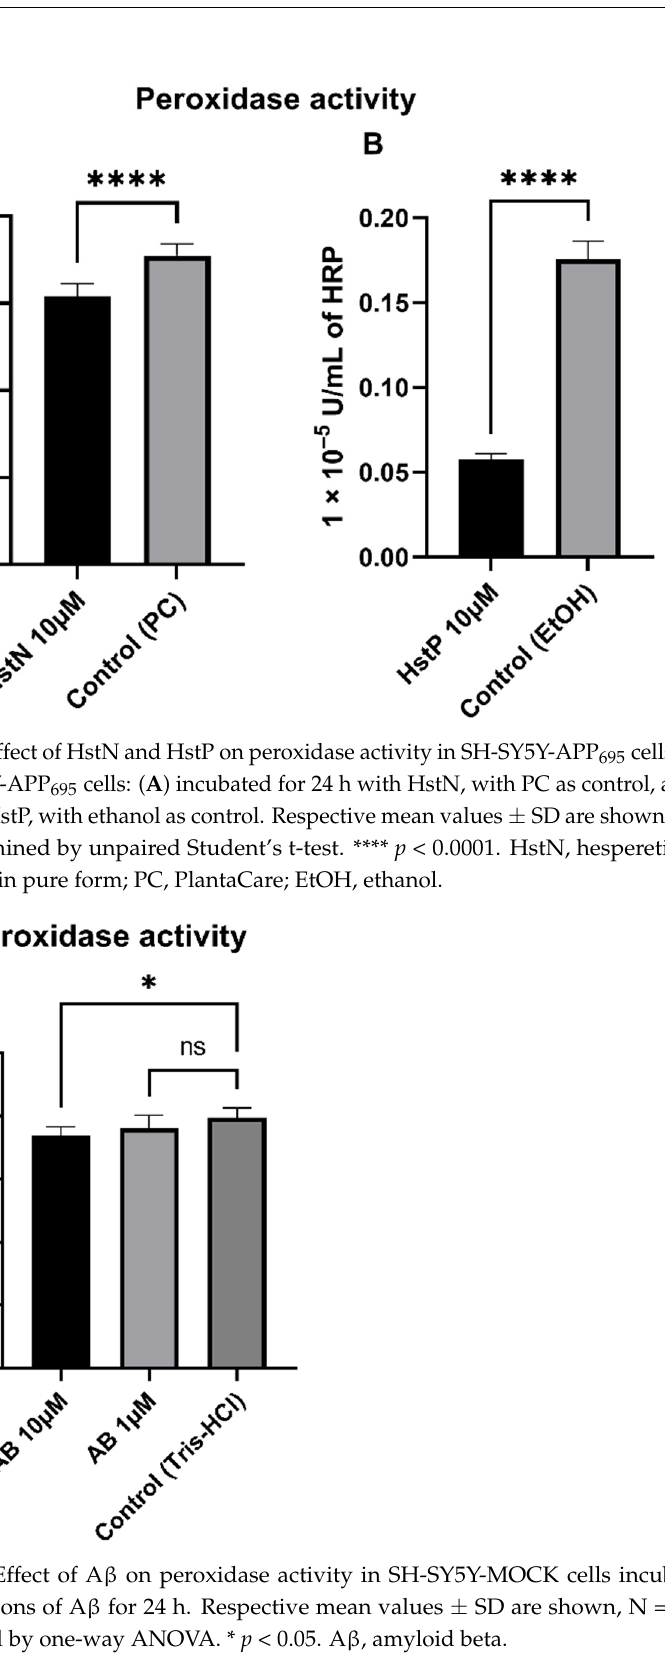
Figure 7. Effect of A β on peroxidase activity in SH-SY5Y-MOCK cells incubated with different con- centrations of A β for 24 h. Respective mean values ± SD are shown, N = 7. Significance was deter- mined by one-way ANOVA. * p < 0.05. A β , amyloid beta. 3.8. Peroxidase Activity of Cytochrome c